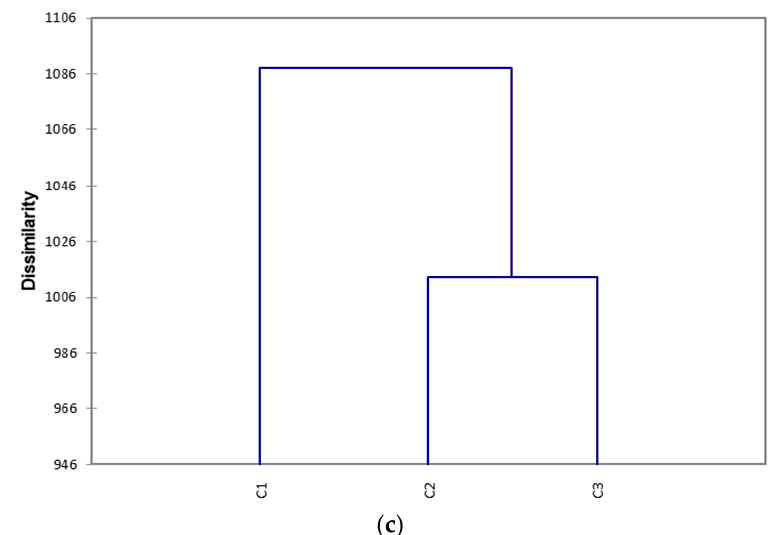
Figure 2. Principal component analysis (PCA) and agglomerative hierarchical clustering (AHC) for the pre-transplant baseline IGH repertoires in all 14 renal transplant patients. ( a ) The PCA charts represent the observations in the PCA space. A new set of variables or principal components (PCs) were created, explaining the maximum variance of datasets, followed by PC2, and so on. X and Y axes show principal components 1 (F1) and 2 (F2), and the percent variation explained by each component is shown in parenthesis; ( b ) sample view and ( c ) cluster view of AHC, C1, C2, and C3 on X axis represent different clusters of gene expression. All the numbers in the figures represent sample numbers rather than patient numbers due to original designations. the numbers 1-0, 2-0, 3-0, 4-0, 5-0, 6-0, 11-0, 12-0, 13-6, 14-0, 15-0, 17-0, 18-0, and 19-0 stand for samples from patient number 1, 2, 3, 4, 5, 6, 7, 8, 9, 10, 11, 12, 13, and 14 at T0 (just at the time of transplantation surgery).